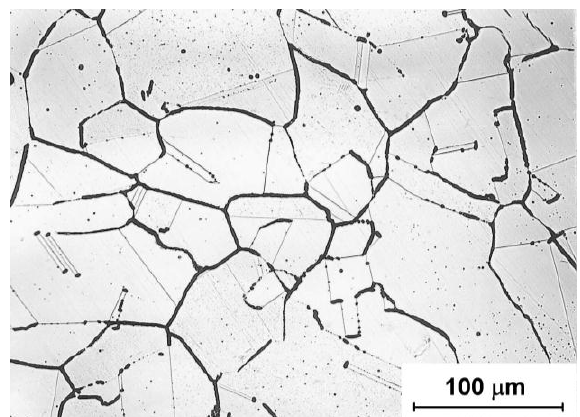
Figure 3. Microstructure of 316L steel after solution annealing by regime 1050 °C/1 h/water and sensitization annealing by regime 600 °C/24 h/water.